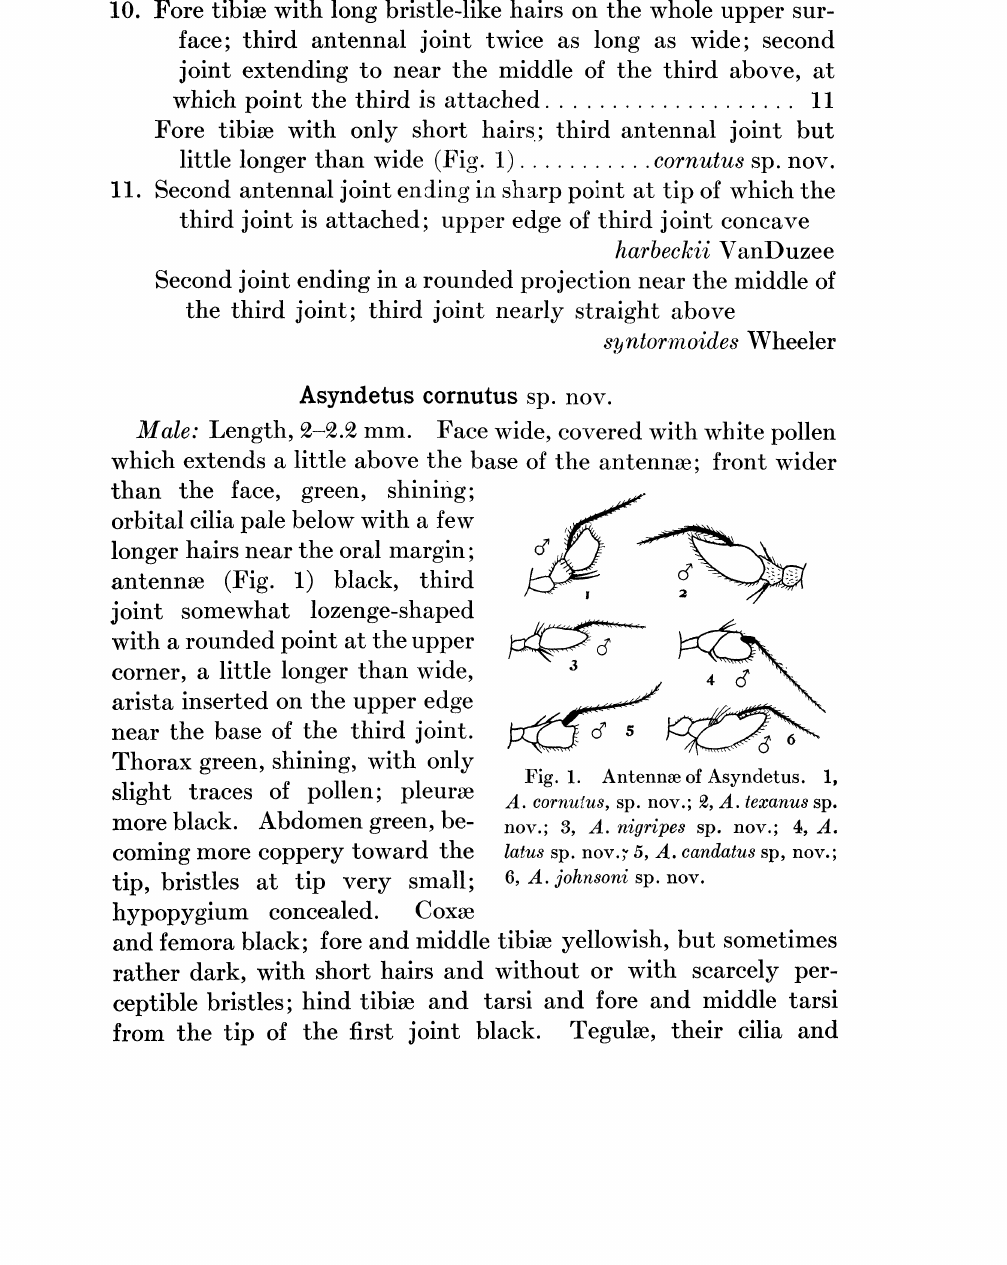
Fig. 1. Antennae of Asyndetus. 1, A. cornufus, sp. nov.; 2, A. texanus sp. nov.; 3, A. nigripes sp. nov.; 4, A. latus sp. nov.;" 5, A. candatus sp, nov.; 6, A. johnsoni sp.